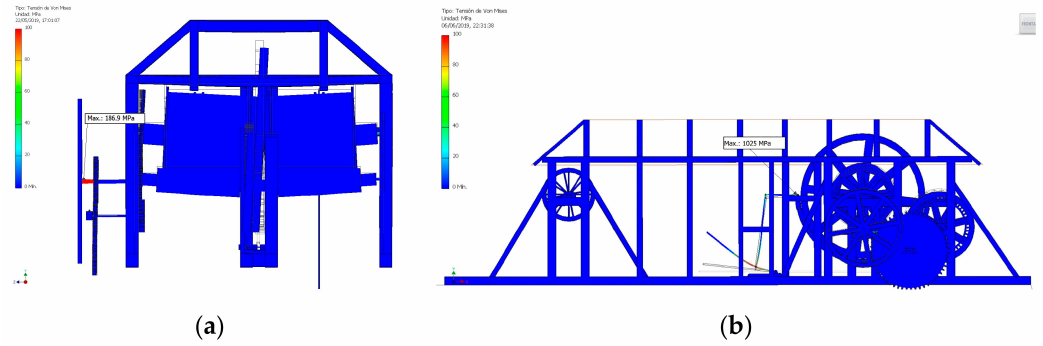
Figure 18. Location of the highest von Mises stress: ( a ) blockage situation and ( b ) braking situation.